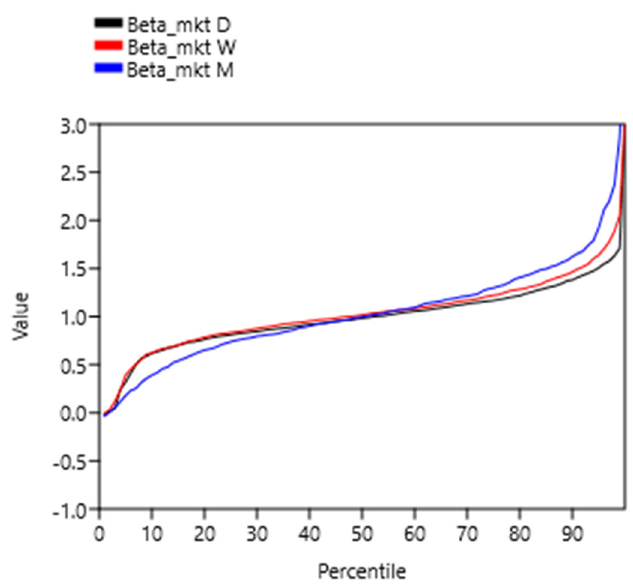
Figure A2. Percentile plot of betas (daily, weekly and monthly return series, 2000 − 2021). The percentile plot or CDF (cumulative density function) for the three beta estimates are shown here. The monthly betas (blue CDF line) have a distinct separation from the daily and weekly beta CDFs. This is also observed in the histograms and from the Jarque-Bera test. Percentiles associated with the beta levels can be read directly off the X-Y point of intersection.